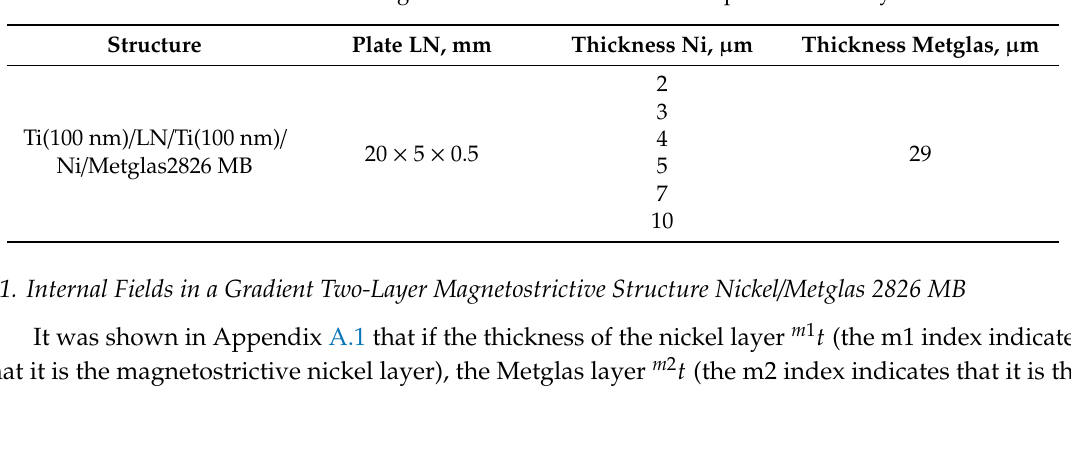
Figure 4. Dependence of the magnitude of the external magnetic field with error bars, at which point the linear section begins, on the nickel thickness. Table 1. Structure and geometric dimensions of the samples under study. Table 1. Structure and geometric dimensions of the samples under